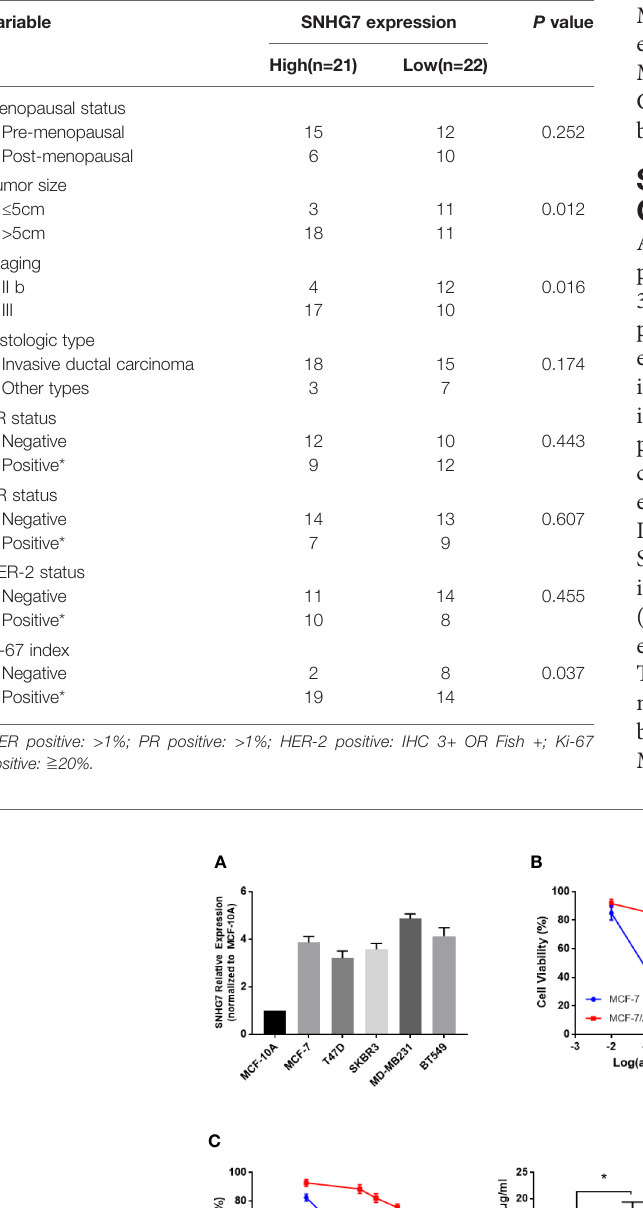
TABLE 3 | SNHG7 expressions and clinicopathologic parameters of BC